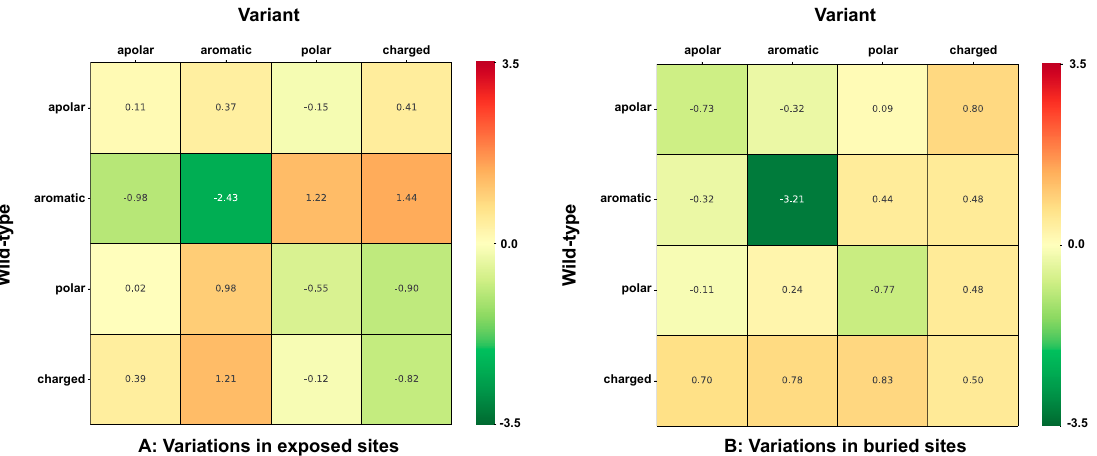
Figure 5. Heatmap shows the strength of association to disease (Log-odds ratio) of variation types in relation to solvent exposure. Variation types are grouped according to chemico-physical properties of lateral side chains. Residues are grouped as following: apolar (GAVPLIM), aromatic (FWY), polar (STCNQH), charged (DEKR). Panel ( A ) shows the association to disease of variations occurring in sites with relative solvent accessibility (RSA) ≥ 20%. Panel ( B ) shows the association to disease of variations occurring in sites with RSA < 20%. Estimated average standard errors on values in Panel ( A ) and ( B ) are 0.24 and 0.18, respectively.